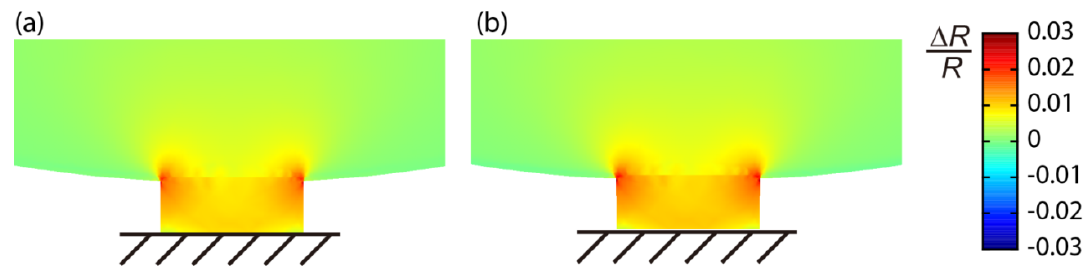
beams of the 2G-MSS chip at 2